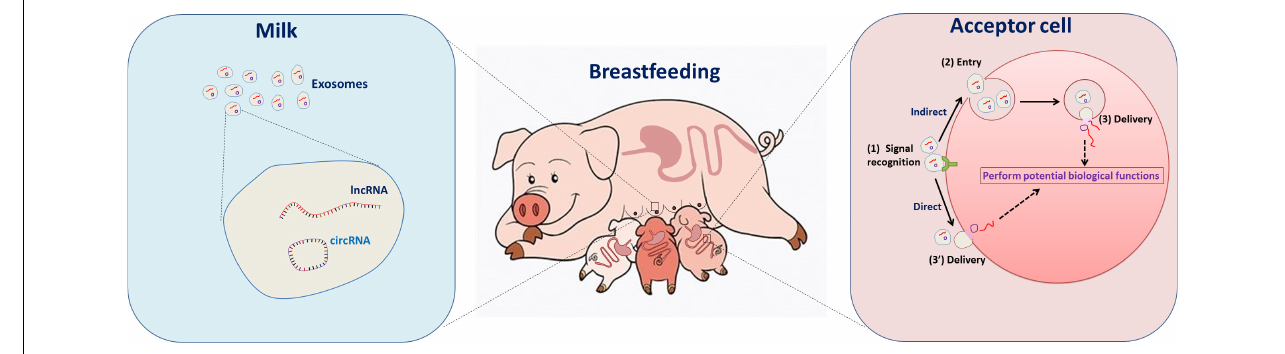
FIGURE 6 | The role of porcine breastmilk exosomal lncRNAs and circRNAs in maternal–infant cell–cell communication: a conceptual model. (Left) The porcine breastmilk contains exosomes loaded with lncRNAs and circRNAs. (Right) The exosome-encapsulated lncRNAs and circRNAs, which are involved in processes such as cell cycle control, immune cell regulation, and cellular macromolecule metabolic processes, can be delivered to the piglet and have direct effects in the intestinal